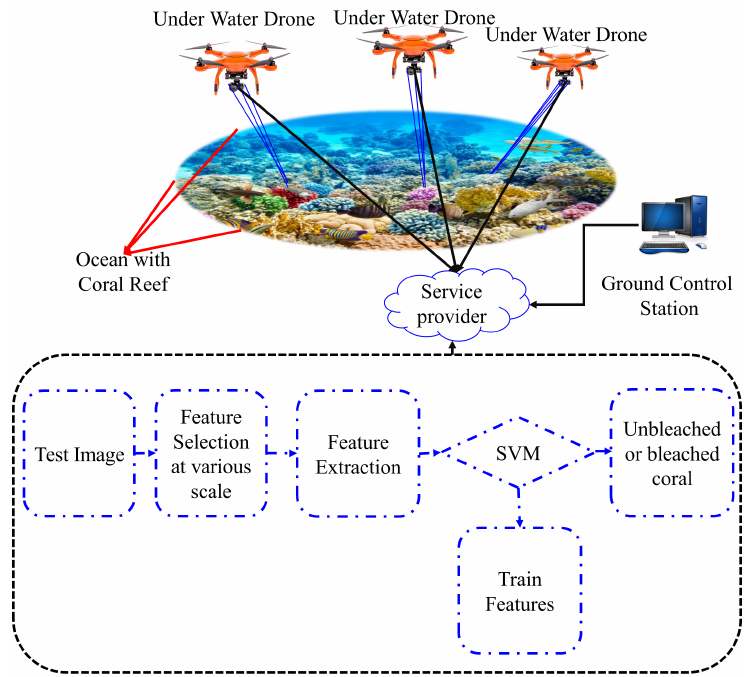
Figure 2. The proposed framework for bleached corals detection.